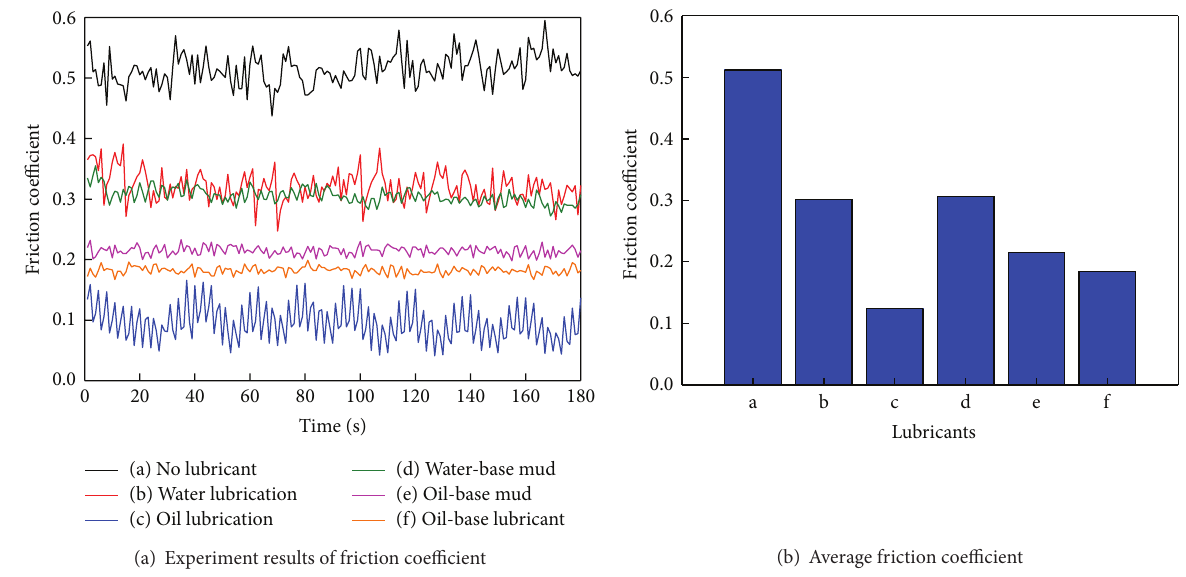
Figure 4: Experiment results of friction coefficients under different lubrication media.